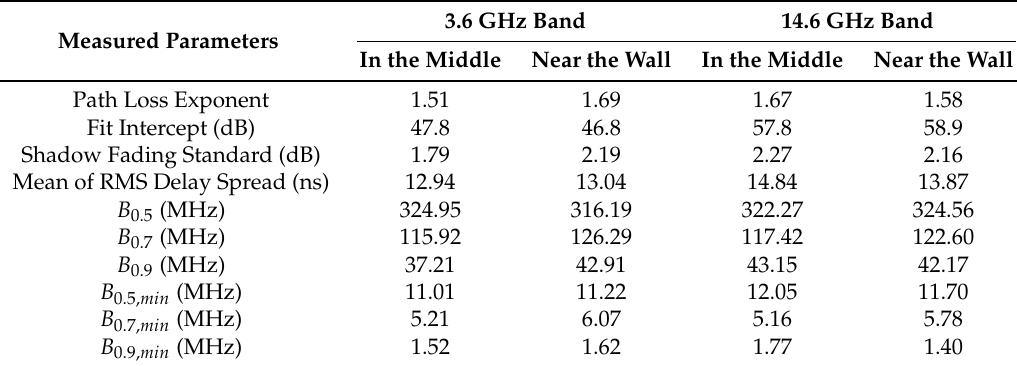
Table 2. Measurement results at the two frequency